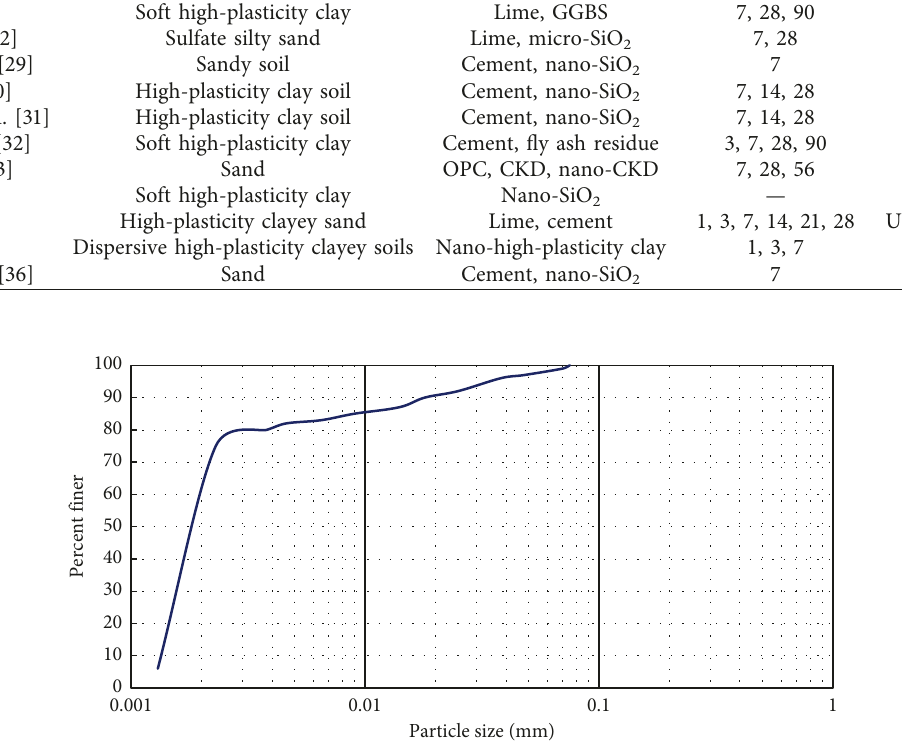
Figure 1: Particle-size distribution of the studied high-plasticity clay soil (obtained according to ASTM D2487-11 [40]). Table 2: Physical properties and Atterberg limits of the studied high-plasticity clay soil.